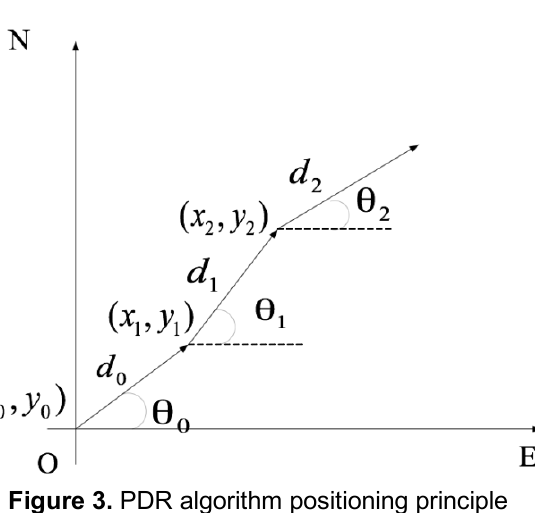
Figure 3. PDR algorithm positioning